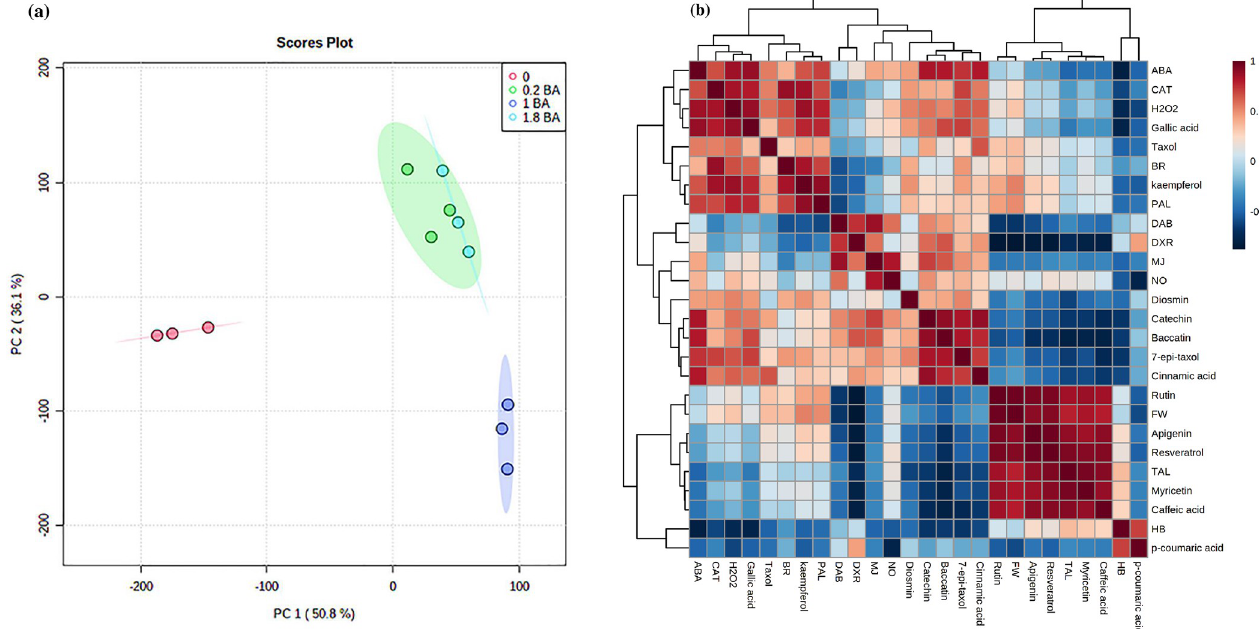
Fig 5. Correlation analysis of metabolites of C . tarraconensis , treated with BA showed by PCA. (a) and HCA (b) . Blue and red respectively show negative and positive correlations in HCA.